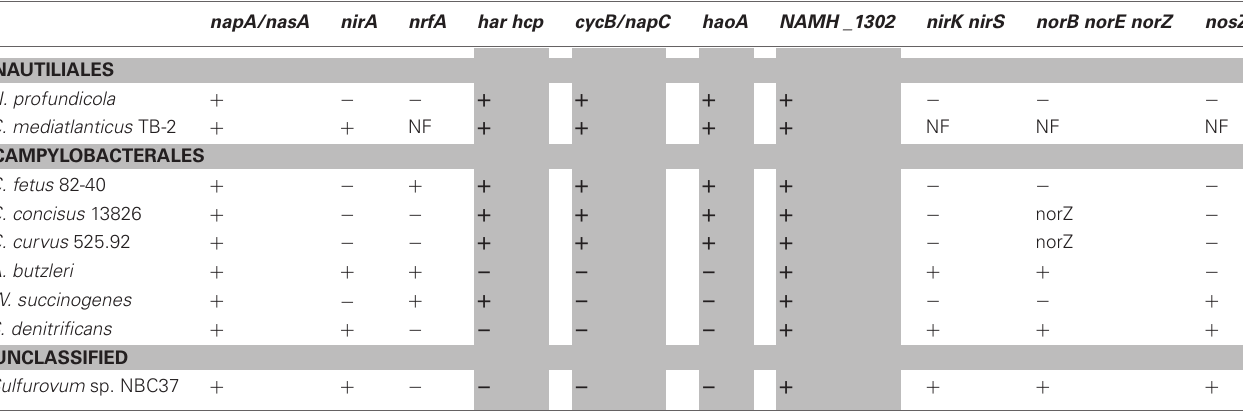
Table 1 | Nitrogen metabolism gene inventories in genome-sequenced Epsilonproteobacteria